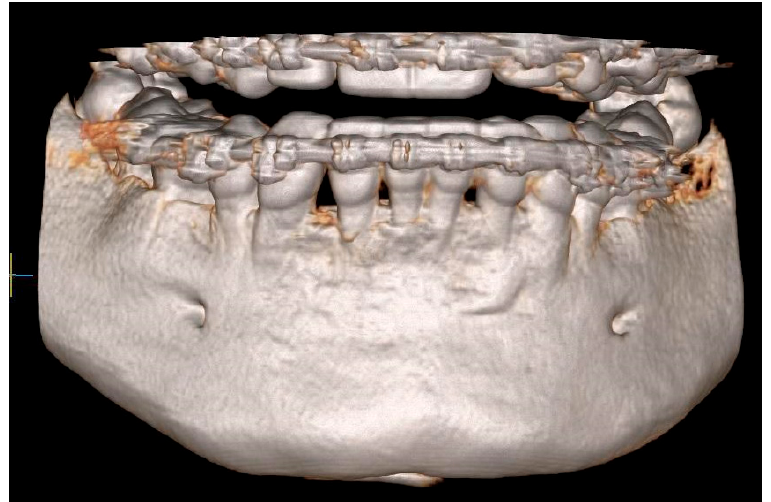
Figure 11. CBCT image two years after the surgical treatment—three-dimensional reconstruction.